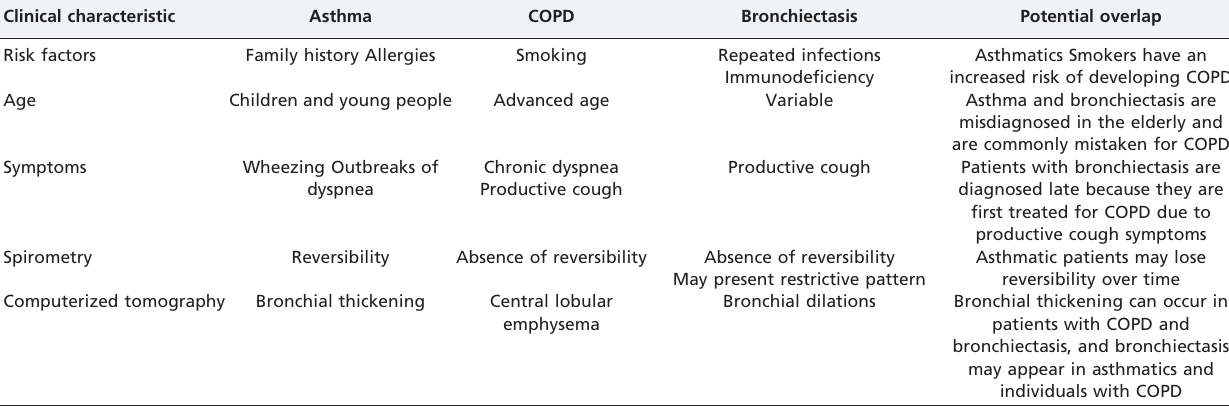
Table 2 - Important clinical characteristics in the differentiation of patients with asthma, COPD and